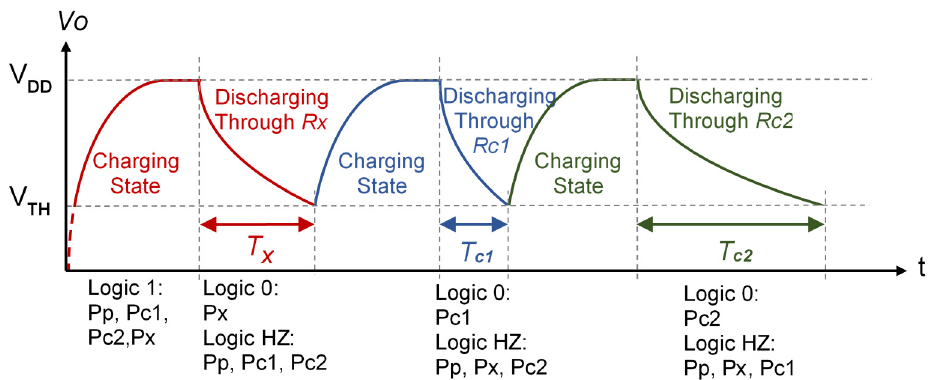
Figure 2. The charging and discharging stages to obtain the T X , T c1 , and T c2 times used in Equation (3) to estimate Rx using the TPCM with the DIC of Figure 1. For each of these stages, the state of the programmable digital device (PDD) pins is indicated under the time axis.